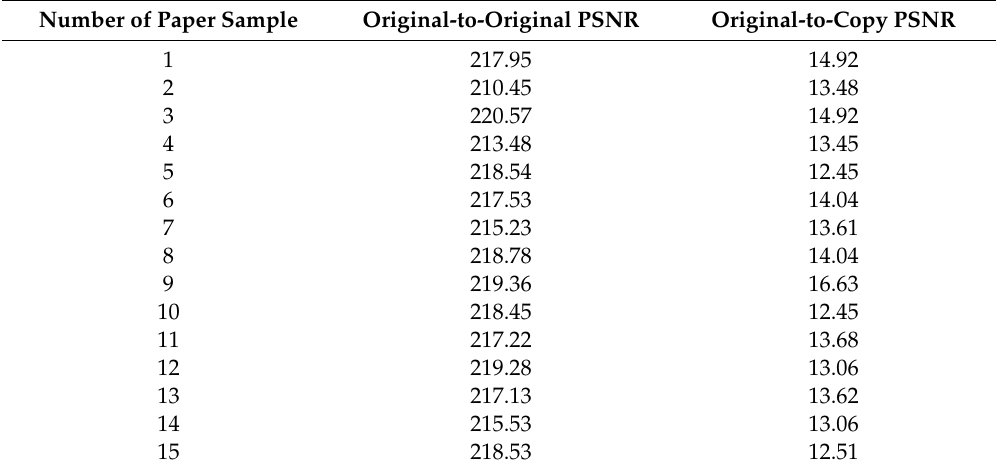
Table 2. The results of using the method of a complete pixel-by-pixel comparison between the security element of the original-to-original and original-to-copy, printed on o ff set